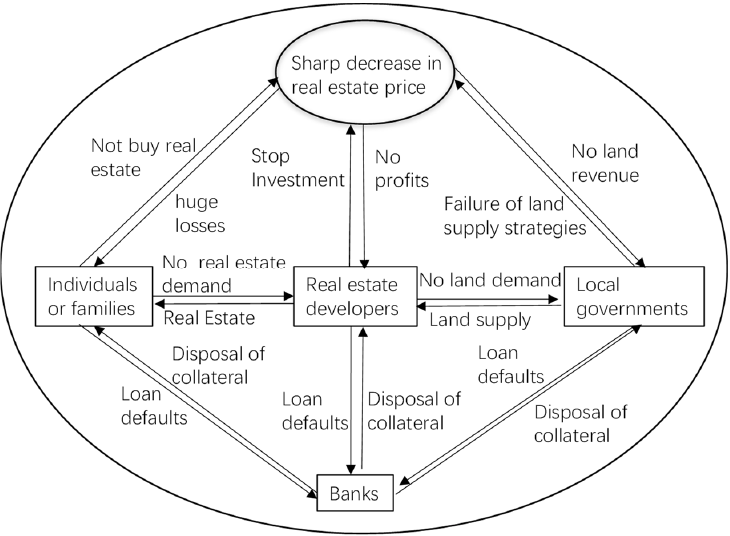
Figure 2. How financial real estate risks involving each sector form. Source: Arranged by the authors.